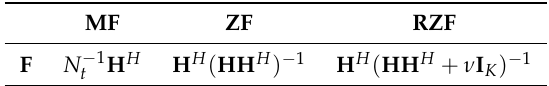
Table 2. The precoding matrices of matched filtering (MF), zero-forcing (ZF) and regularized zero-forcing